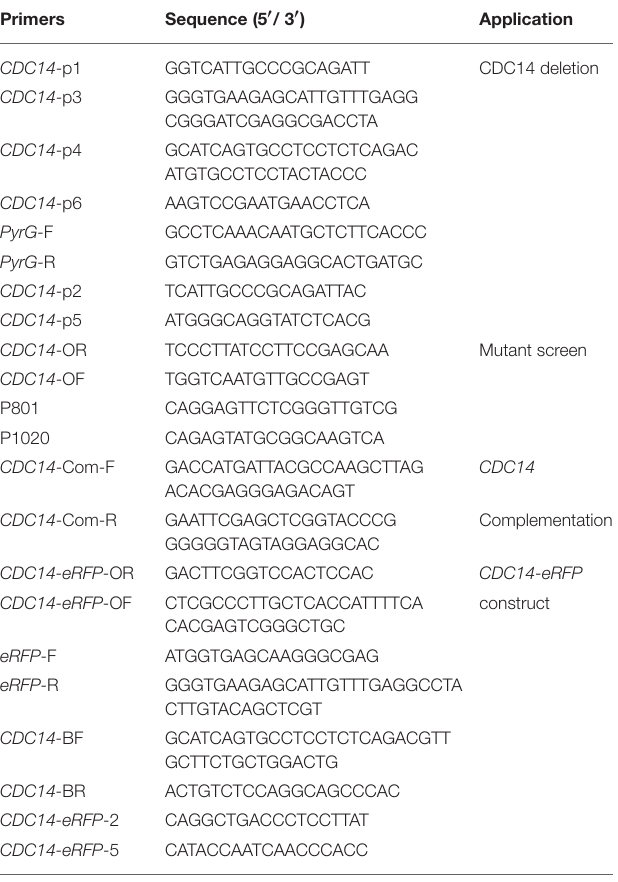
TABLE 2 | Primers used for gene deletion and complementation.